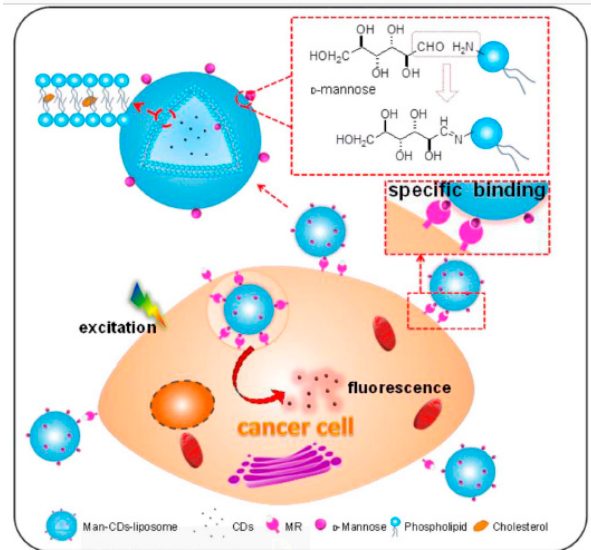
Figure 15. Schematic illustration depicts the structure of Man-CDs-liposome. The process for Man-liposomes loading is displayed. The aldehyde groups of D-mannose can react with the amino on the hydrophilic head of liposomes to form imine by aldehyde-amide condensation reaction. Man-CDs-liposome can target recognition of HepG2 cells. Reproduced with permission from [128]. Copyright Elsevier, 2018.